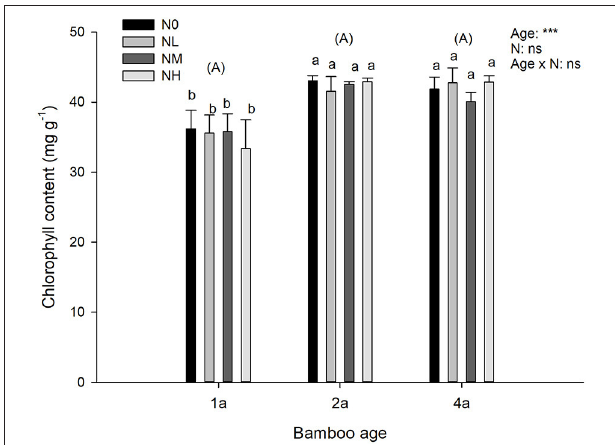
FIGURE 2 | Effects of nitrogen deposition and tree age on chlorophyll content in Moso bamboo leaves in a factorial experiment. One-year-old (1a), 3-year-old (3a), and 5-year-old (5a) trees were included in the experiment. Nitrogen deposition treatments: Ambient deposition with no addition (N0, control), low addition (NL = 30kg N ha − 1 year − 1 ), medium addition (NM = 60kg N ha − 1 year − 1 ), and high addition (NH = 90kg N ha − 1 year − 1 ). Each treatment had three replicates ( n = 3). For the chlorophyll content mean ± SE is indicated. Bars with different lower-case letters indicate significant differences between all combinations of treatment and age, whereas groups of bars with different upper-case letters in parentheses indicate significant differences between the tree age classes ( α = 0.05 in post-hoc one-way ANOVA combined with pair-wise Tukey’s tests). A summary of the results of a two-way ANOVA addressing the effects of nitrogen deposition and tree age is seen in the upper right-hand corner of the panel (*** P < 0.001; ns,